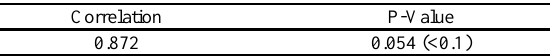
Table 3. Spearman's Rank Correlation Coefficient of SA std and Layer Precision